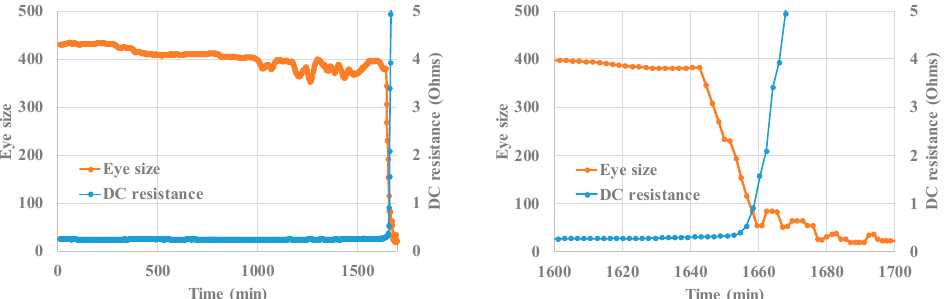
Figure 12. Eye size, DC resistance, and time to failure based on the feature set (Test #1).